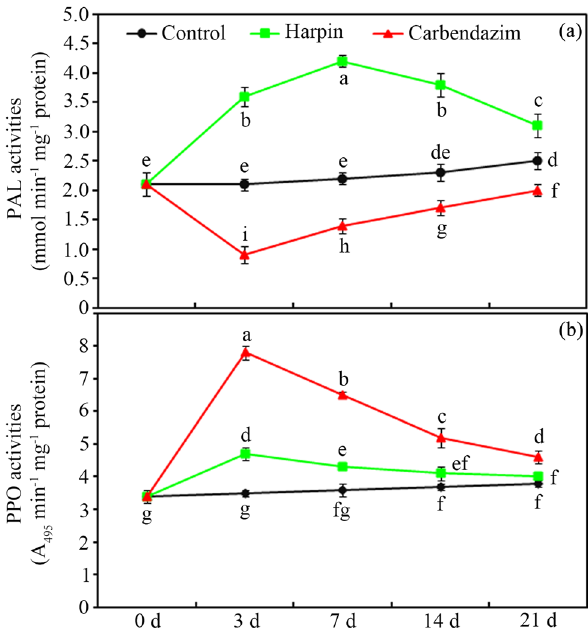
Figure 3: Phenolic - related enzyme activities. E ff ects of harpin ( 30 mg L − 1 ) and carbendazim ( 1,000 mg L − 1 ) on PAL ( a ) and PPO ( b ) activities in young leaves after treatment for 0, 3, 7, 14, and 21 days. Bars represent the standard deviations of the means ( n = 3 ) . Numbers with the same letter were not signi fi cantly di ff erent ( p < 0.05 ) . PAL, phenylalanine ammonia - lyase; PPO, polyphenol oxidase.